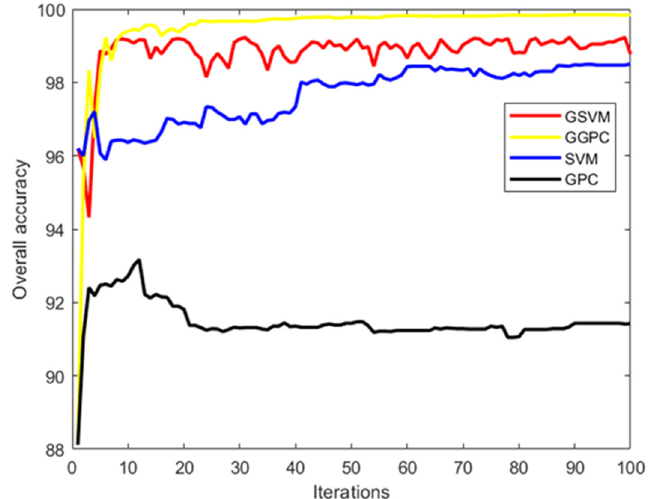
Figure 8. The performance of the four classi fi ers in classifying critical and non-critical car-following scenarios.